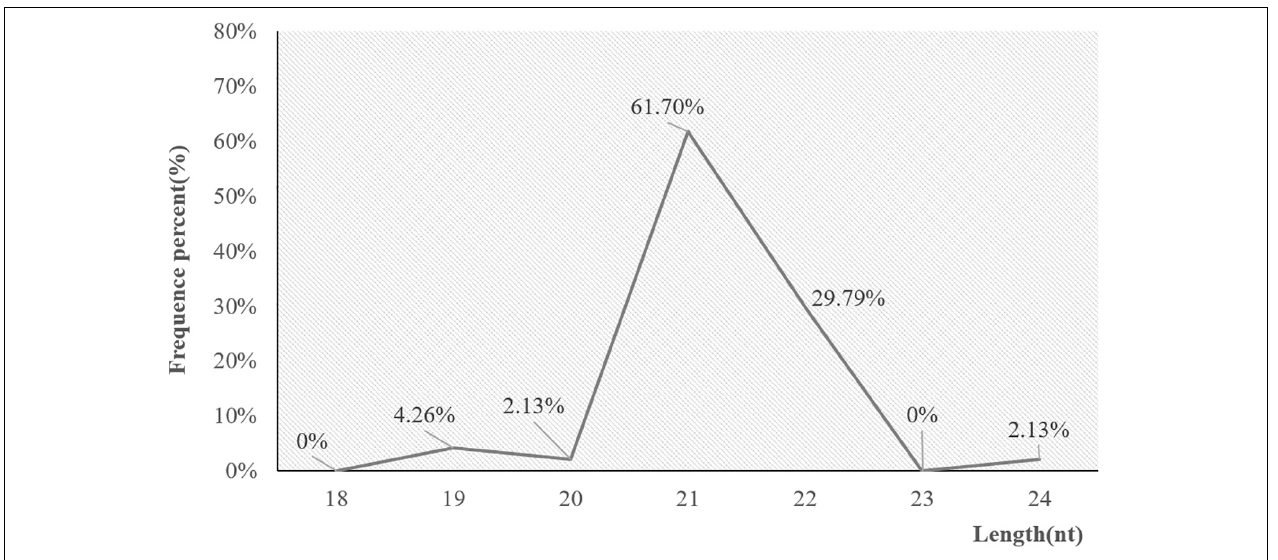
FIGURE 1 | The length distribution of identified